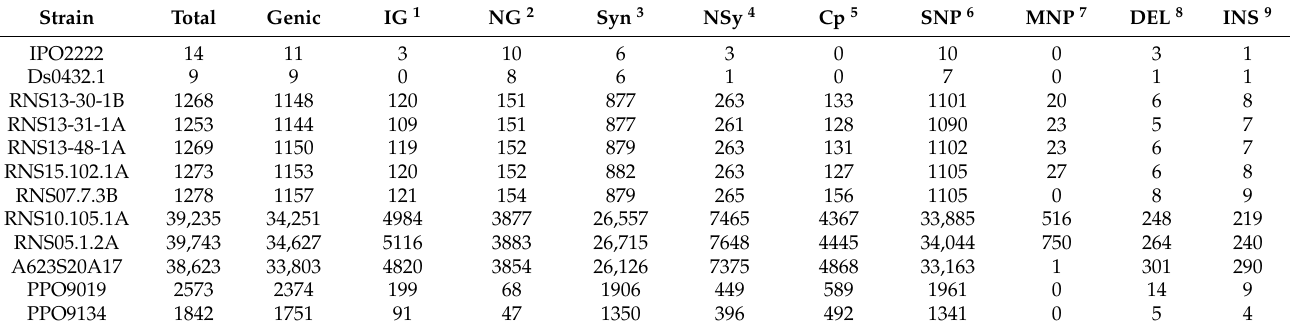
Table 1. Statistics of variants identified within 12 D. solani strains against the strain